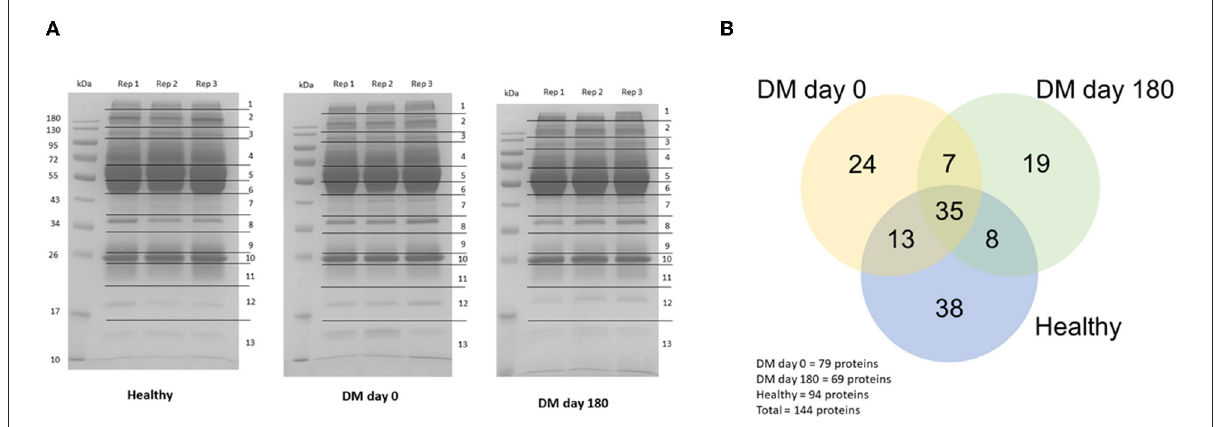
FIGURE2 Protein detection. (A) 1D-Gel electrophoresis with Coomassie blue R-250 staining. (B) Venn diagram ( Canis lupus familiaris